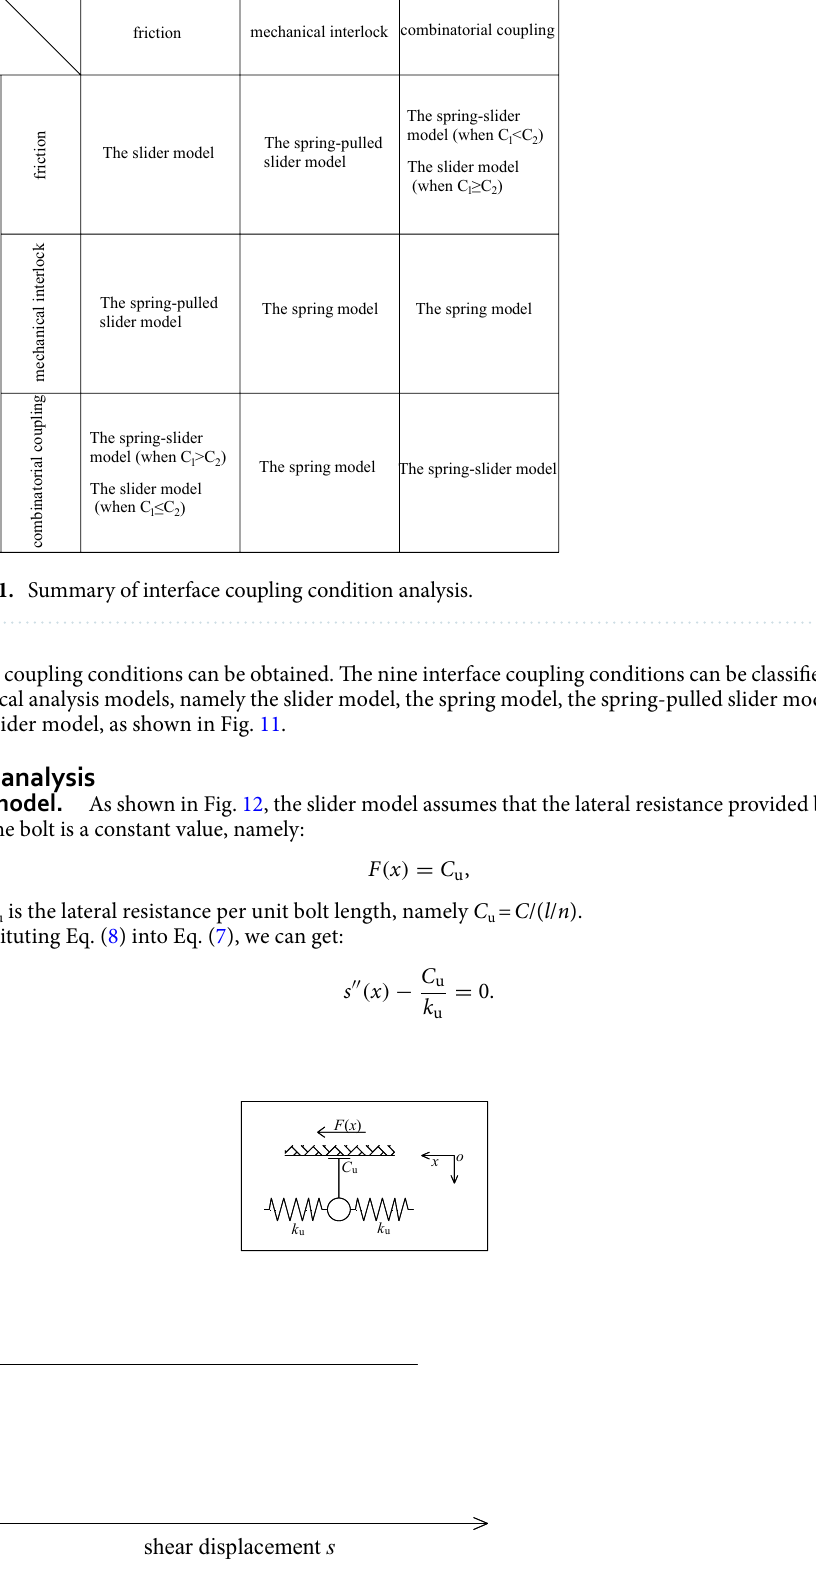
Figure 12. Schematic diagram of slider